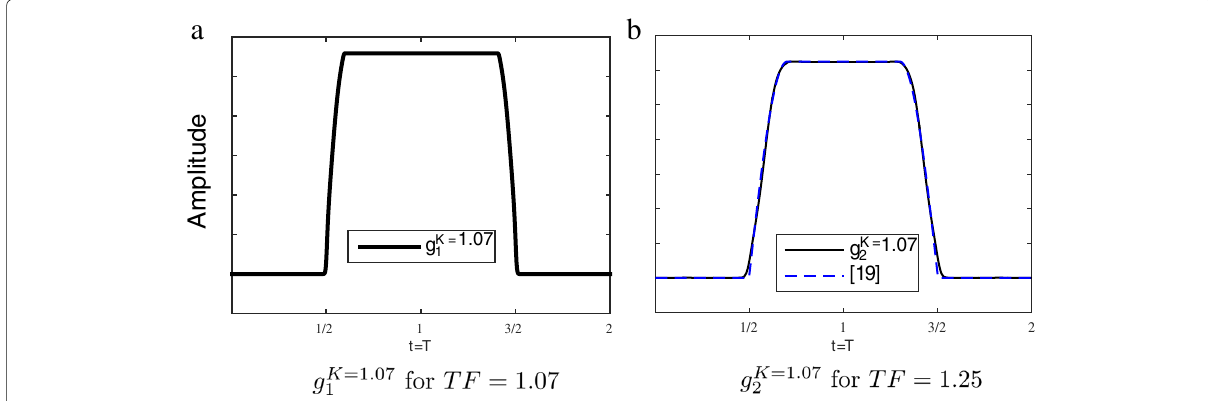
Fig. 5 a , b Orthogonal pulse shape design for K =